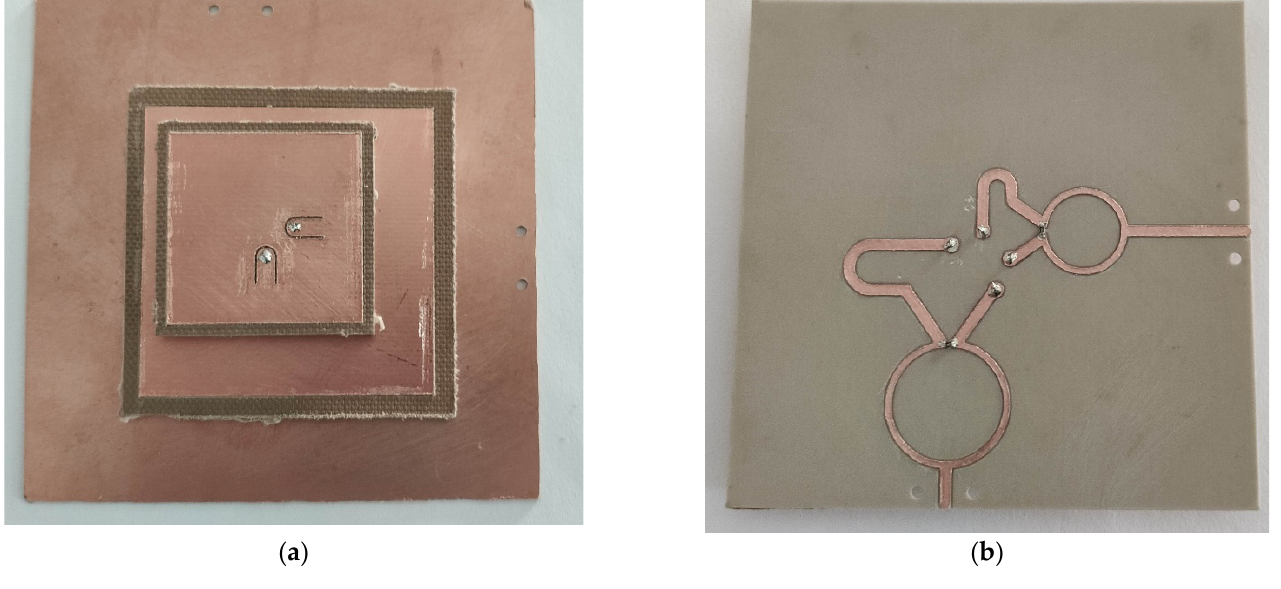
Figure 8. Fabricated antenna ( a ) top view; ( b ), bottom view.